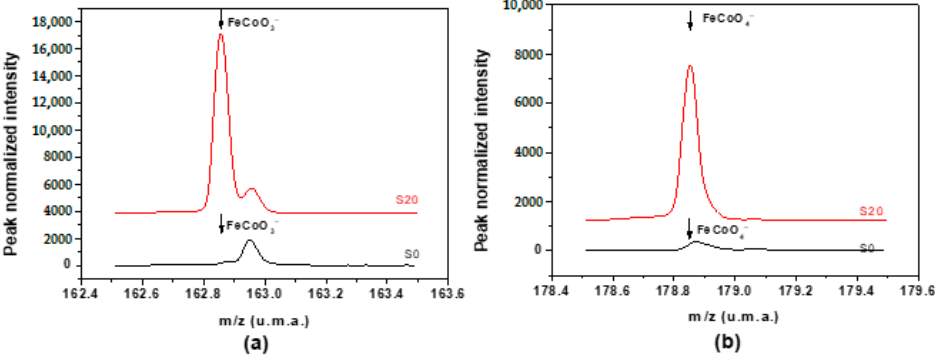
Figure 9. Partial negative spectra of S0 and S20 decomposition products showing the ( a ) FeCoO 3 − ;( b ) FeCoO 4 − peak. The peak’s intensities are normalized with the respect to the total spectrum intensity (total spectrum).